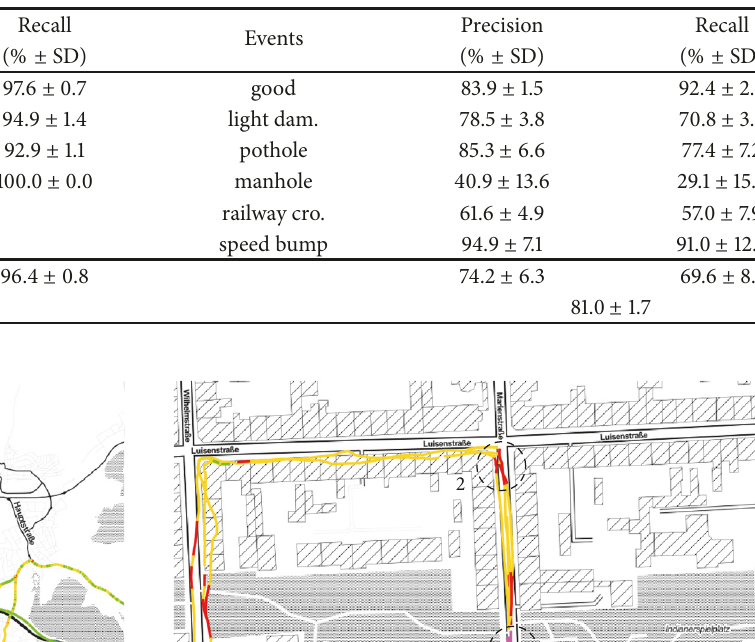
Table 2: Results of single features classification.